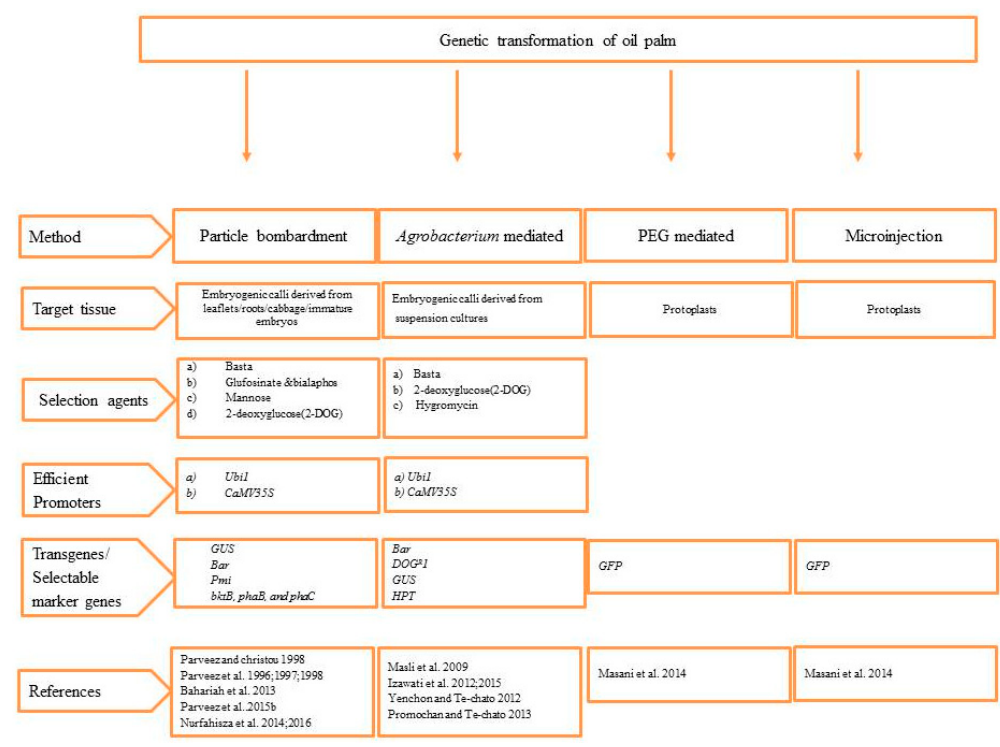
Figure 2. Genetic transformation methods established in oil palm.